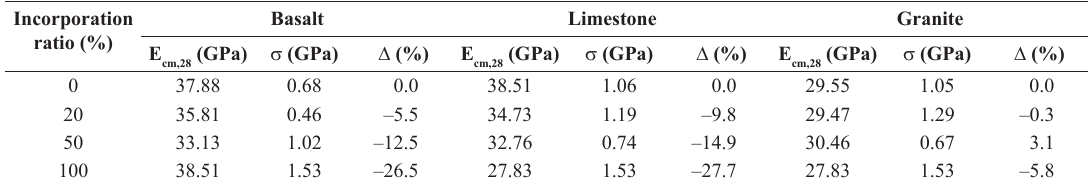
Table 6. Elasticity modulus at 28